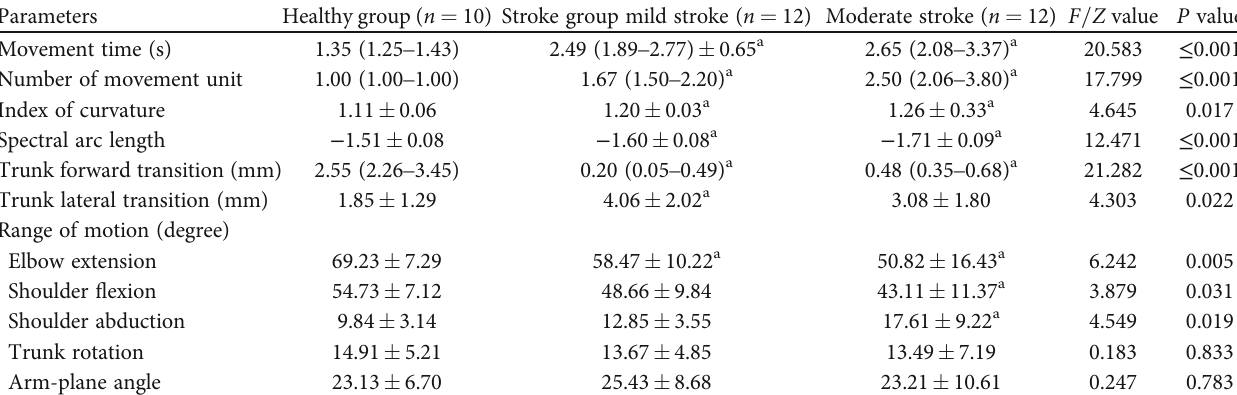
T ABLE 2: Kinematic characteristics of the reach-to-grasp-pen task in healthy and stroke